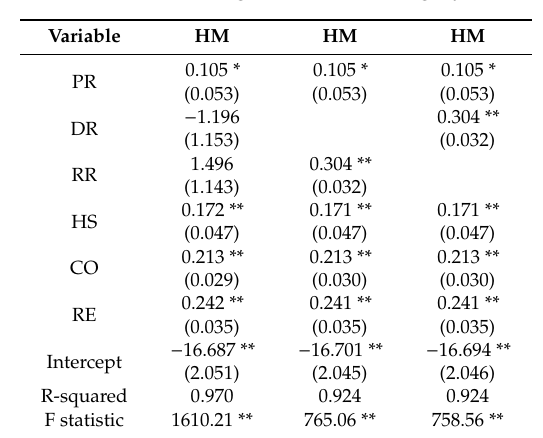
Table 9. Ordinal scores of HM regressed on six category ordinal